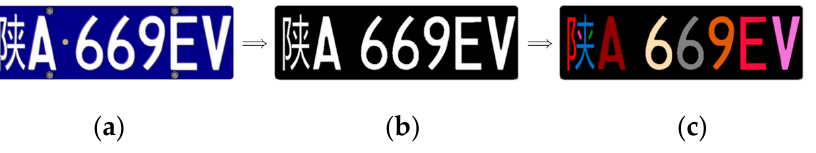
Figure 19. The example of license plates, “ 陕 ” in figure means Shanxi Province. ( a ) original image. ( b ) binary image. ( c ) component Figure 18. The example of traffic signs. ( a ) original image. ( b ) binary image. ( c ) component labeling.